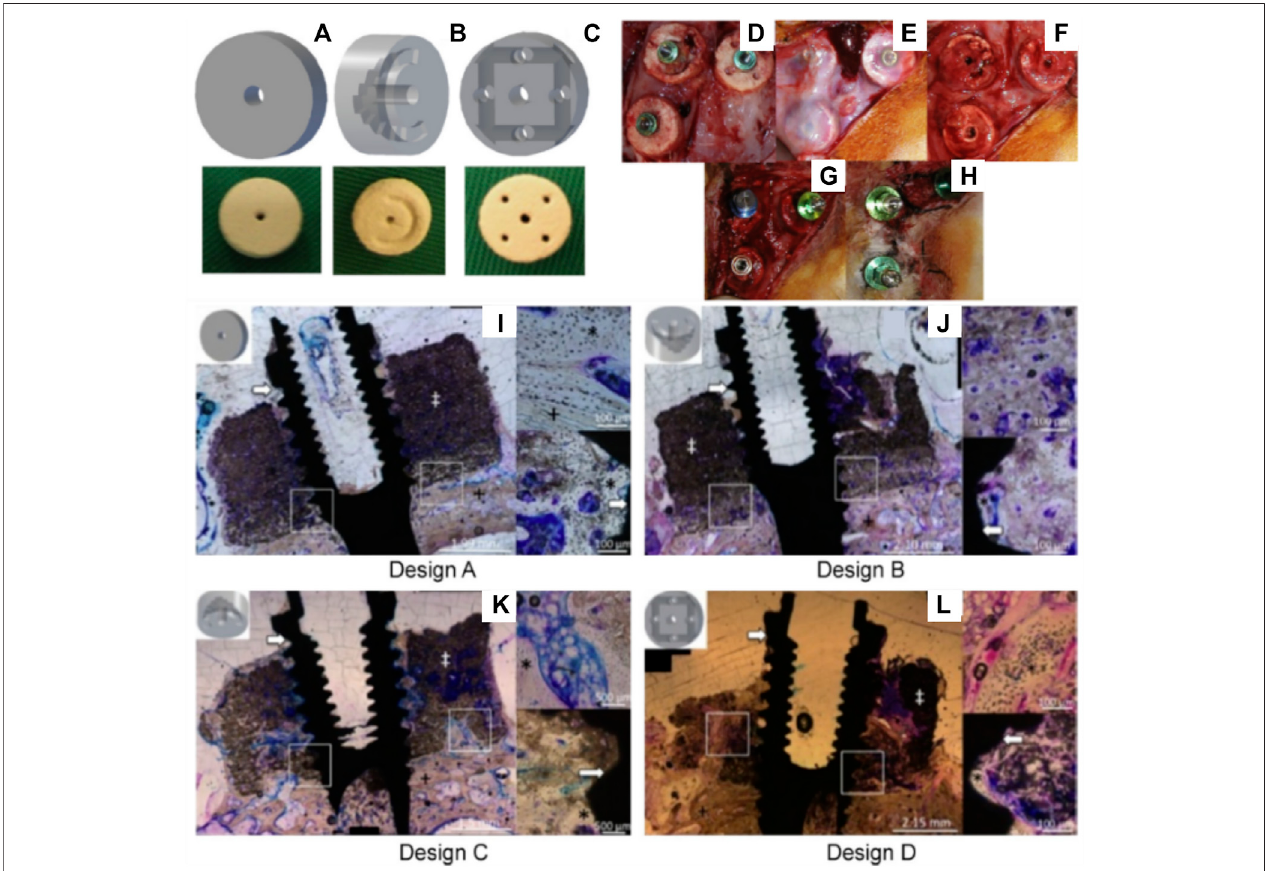
FIGURE 3 | Assessment of the bone formation performance of 3D-powder printing including various microporosity in the forms of semi-circular grooves and channels in a lapine extraskeletal model. (A) : Design A “ control ” 3D-printed monetite scaffold, (B) : Design B and C including a semi-circle shaped groove spanning half the diameter of the scaffold, with the semi-circle in con fi guration B facing away from the calvarial bone, whilst the semi-circle in con fi guration C faced the calvarial bone, (C) :DesignDconsistingofanarrayofeightinterconnectedchannelscreatingmultipleaperturesoneachsurfaceofthescaffold, (D) :surgical fi xationofthescaffold, (E) :surgicalre-entryat4 weekspost-implantation, (F) :removalofthe fi xationscrews, (G) :Dentalimplantplacement, (H) :appearanceofthespecimensat4 weekspost- implant placement. (I – L) Tissue morphology as demonstrated by histology, indicating that the presence of the channels was bene fi cial to bone formation, although the overall amount of bone tissue was not greatly increased and its distribution remained heterogeneous. Reproduced with permission from (Tamimi et al., 2014).